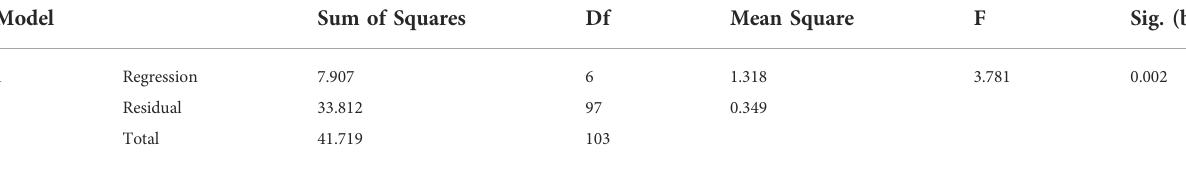
TABLE 9 ANOVA corresponding to the dependent variable for